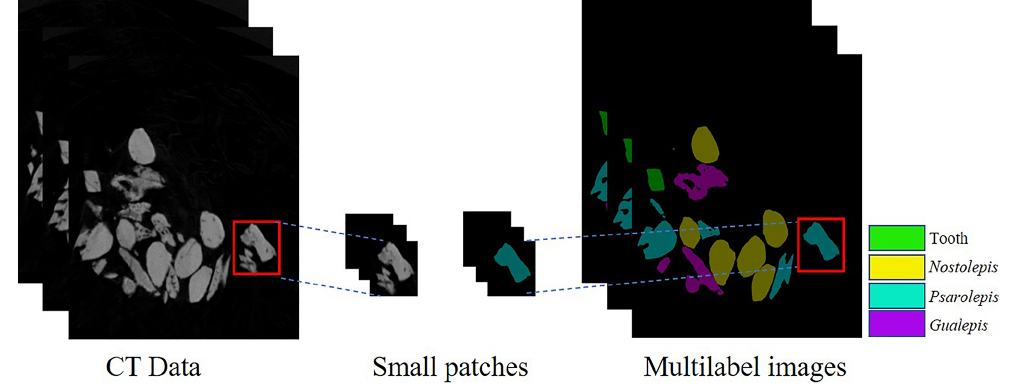
Figure 4. Random cropping of CT data and labels with patches of 256 ×256 pixels.